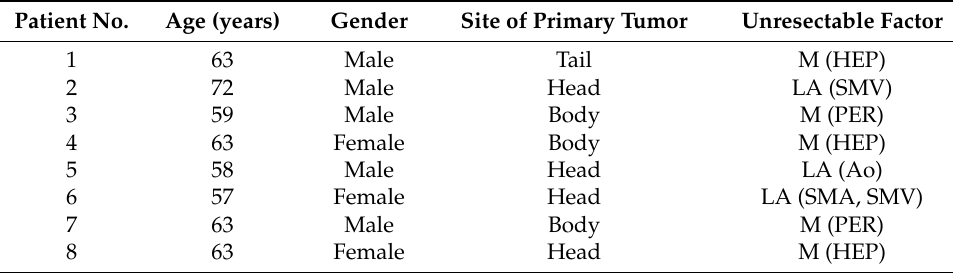
Table 2. Basic characteristic of patients underwent conversion